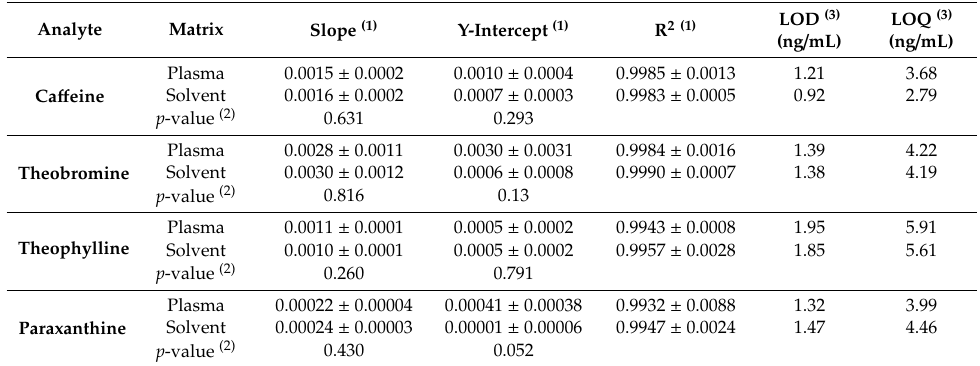
Table 1. Linear regression parameters using the weighting factor 1/x 2 for the calibration curves of caffeine, theobromine, theophylline, and paraxanthine prepared in solvent and plasma for five non- consecutive days.